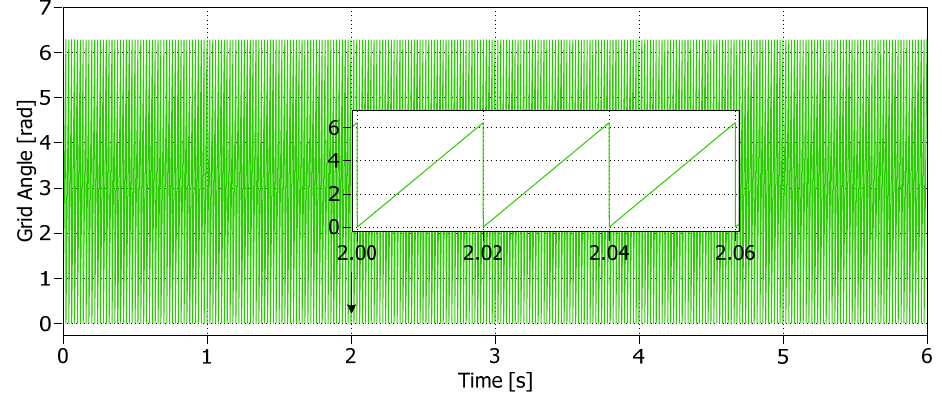
Figure 6. Grid angle variation.